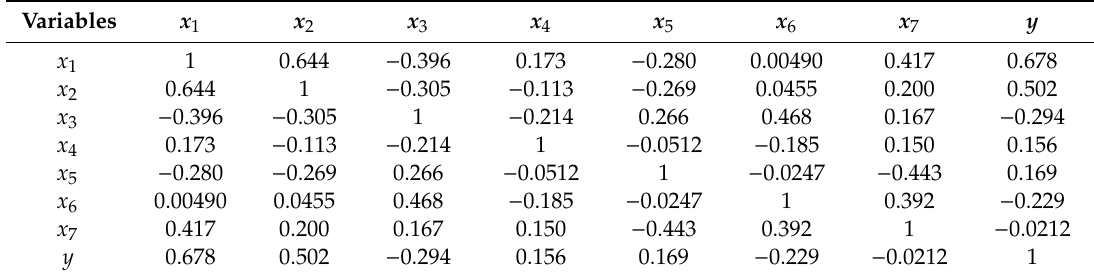
Table 3. Correlation coefficient matrix of the predictors and response variable in the leach data set.